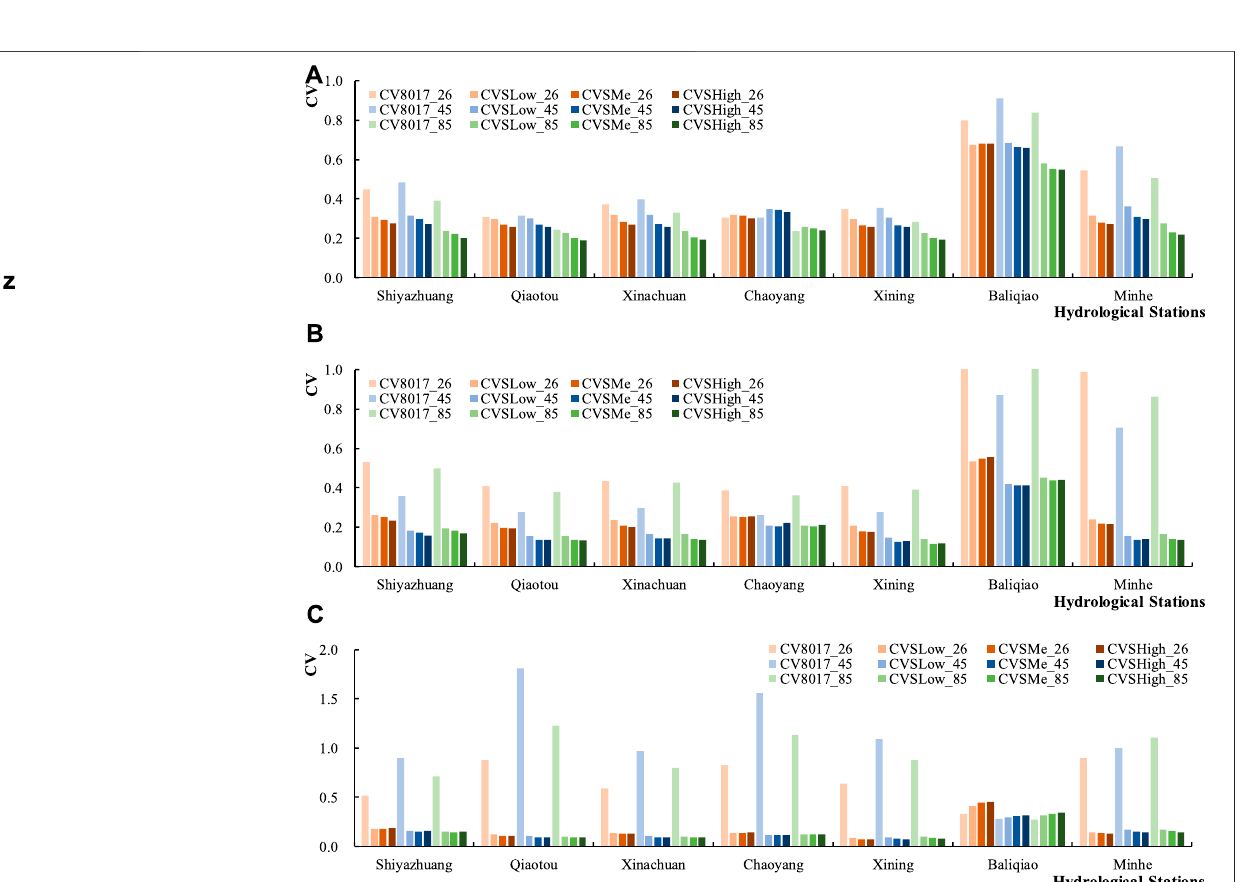
Frontiers in Earth Science |